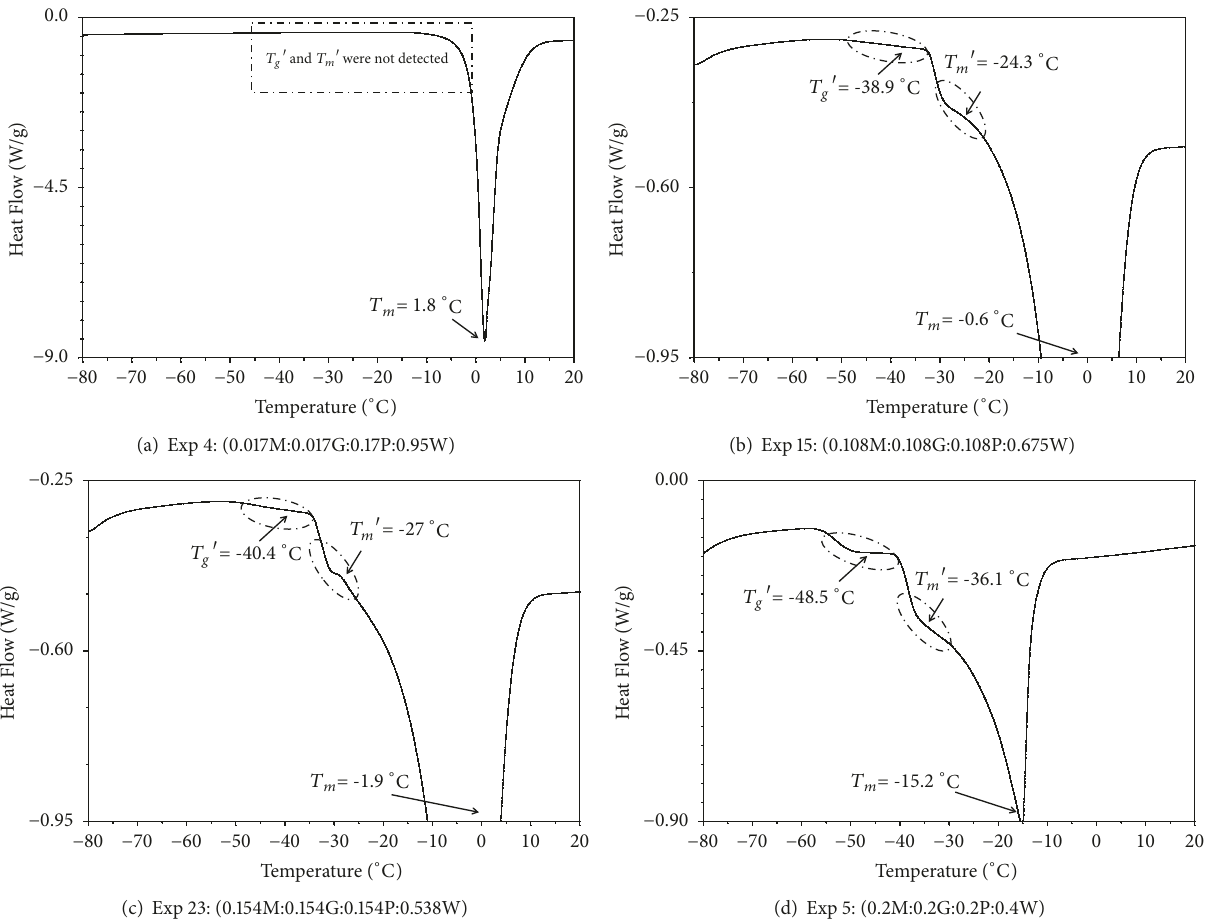
Figure 2: Phase and state transitions analysis of frozen ternary cryoprotectant solutions prepared at moisture contents in the range of 40–95% < 0.95) : (a) Exp 4, (b) Exp 15, (c) Exp 23, and (d) Exp 5. Exp 23 and Exp 5 were annealed for 30 min at ( 𝑇 wet basis ( 0.4 < 𝑋 W